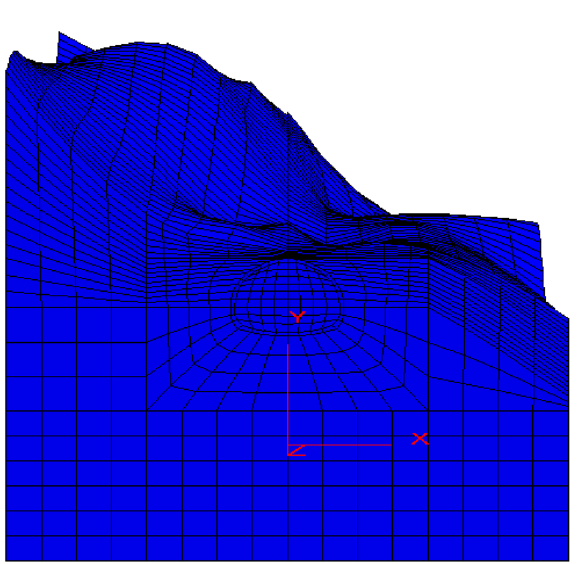
Figure 4. Numerical calculation model of the left entrance of the Beikou tunnel.